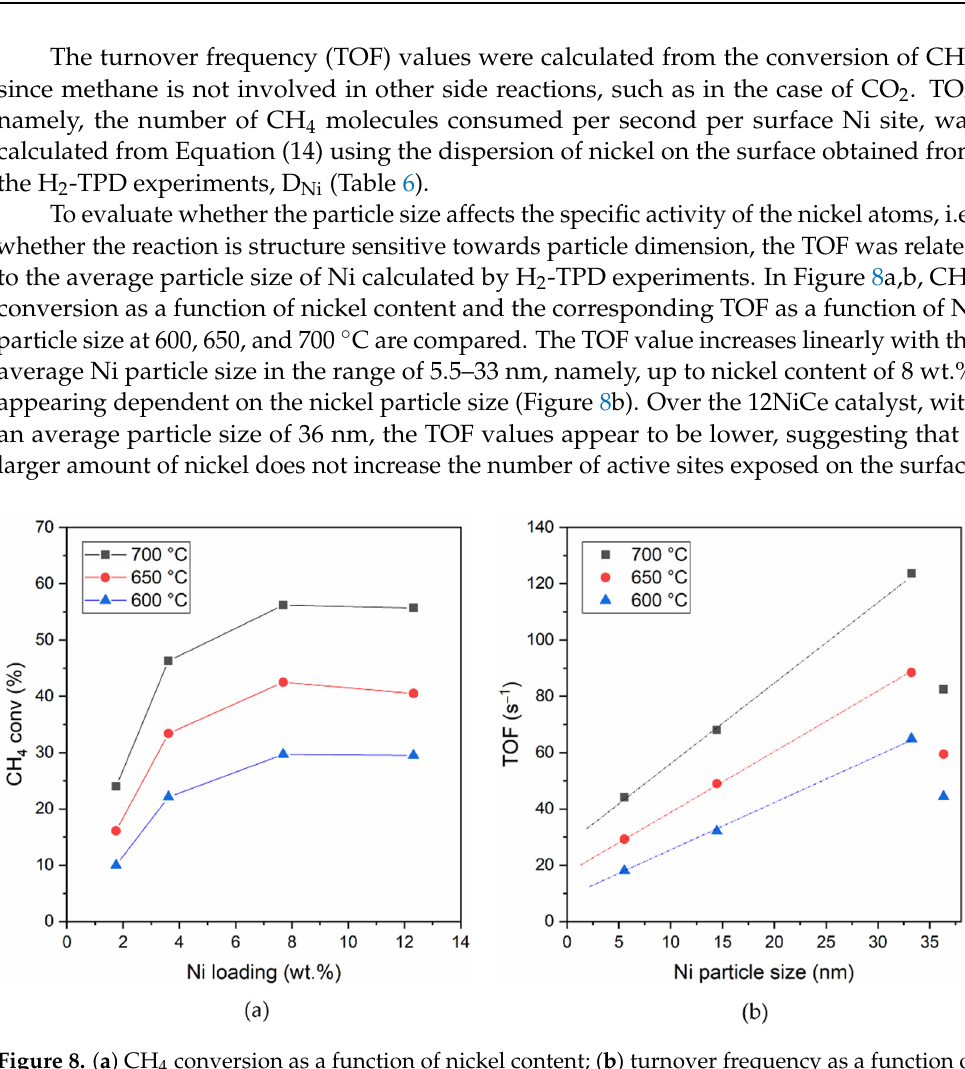
Table 6. Apparent activation energy, conversions, and the corresponding turnover frequency (TOF) values over xNiCe catalysts.